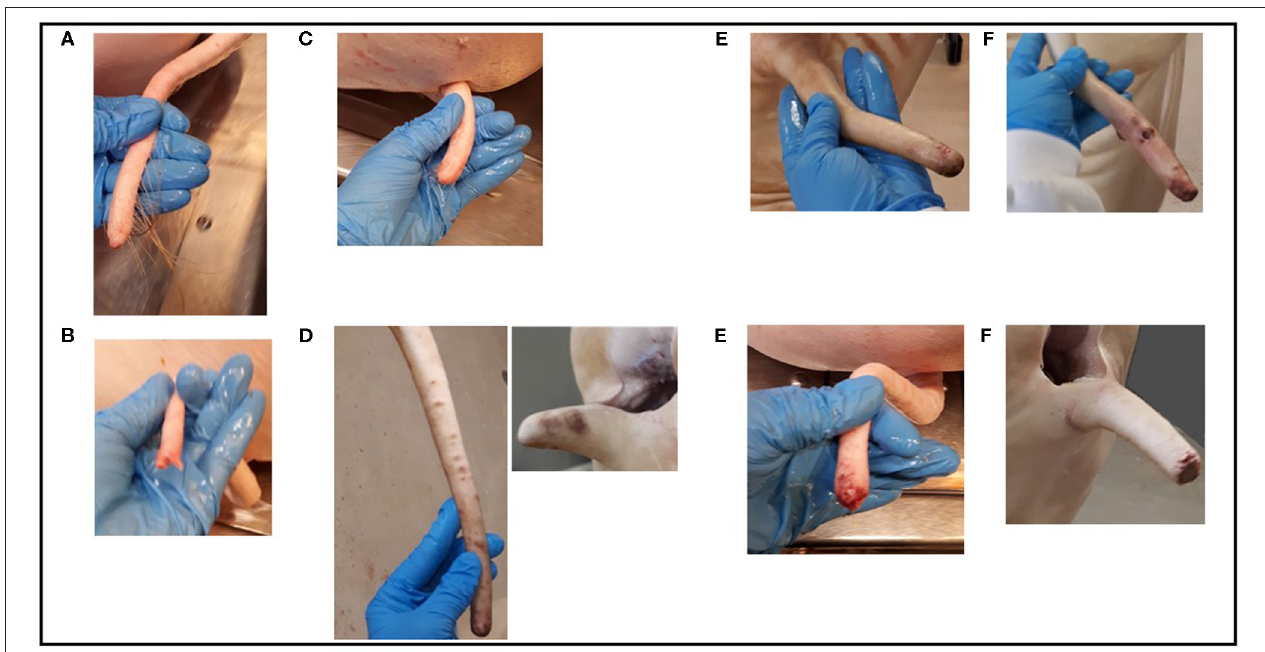
FIGURE 1 | Example pictures of tails scored according to the scoring system used after scalding (See Table 1 and section Tail length measurement and scoring system for details): (A) intact tail; (B) broken tail; (C) healed tail; (D) healed tails with bite marks or bruises; (E) tails with minor acute wounds of different severity; (F) tails with major acute wounds of different severity. This figure was generated by Elina